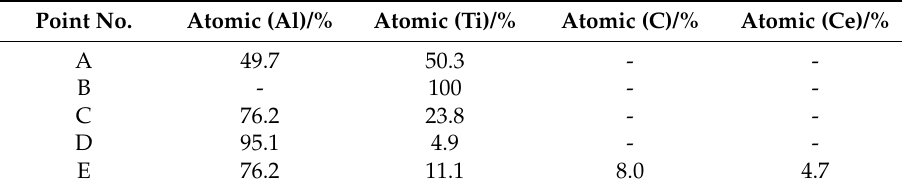
Figure 5. SEM images of pressing blocks at 60 s of: ( a ) 2#; ( b ) 3#; ( c ) 4#; ( d ) 5#; ( e ) TiC particle mass in Figure 5d. Table 3. Energy dispersive spectrometer (EDS) composition analysis of point A, point B, point C, point D, and point E in Figure 5d.